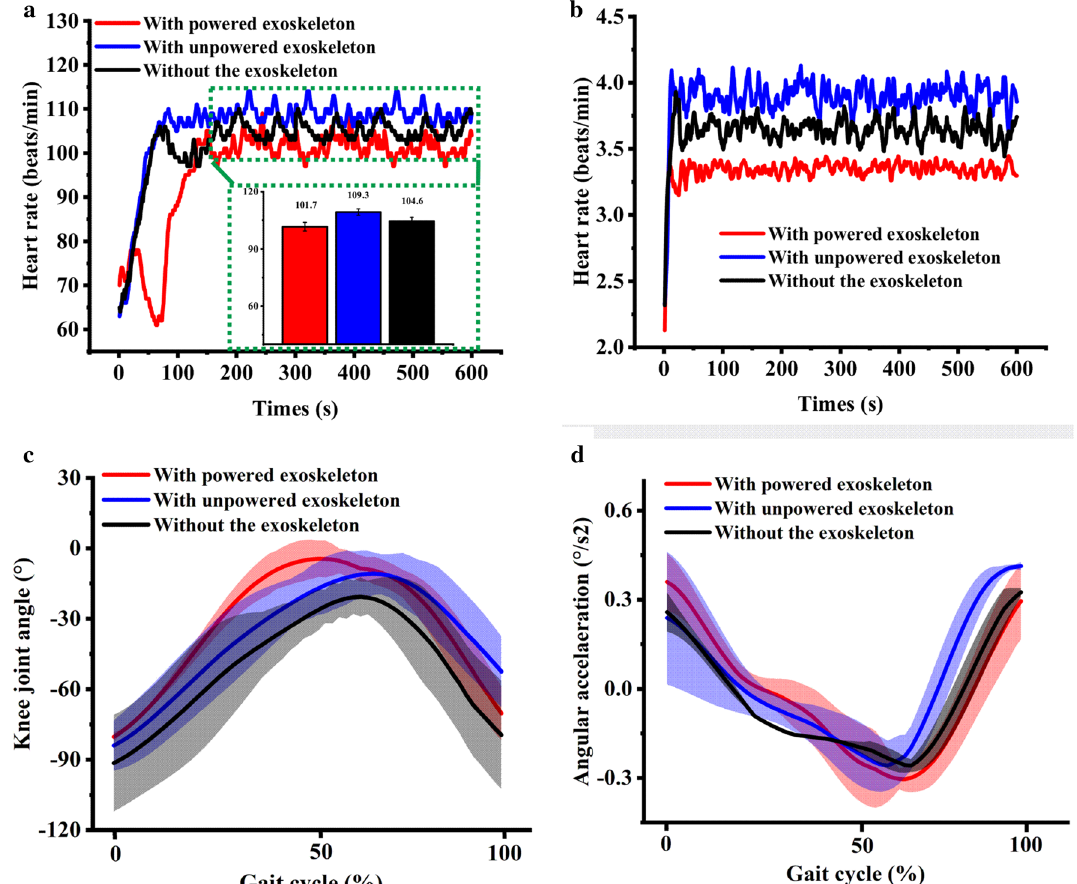
Figure 6. Kinematics and metabolic cost data of the subject with three conditions at the intermediate phase. ( a ) Heart rate value of the subject with three conditions, the average HR were inserted in green box; ( b ) MET changes in the subject with time during three conditions; ( c ) knee joint angle varies with time while walking upstairs; and ( d ) knee joint angular acceleration varies with time while walking upstairs, the shaded area represent the standard